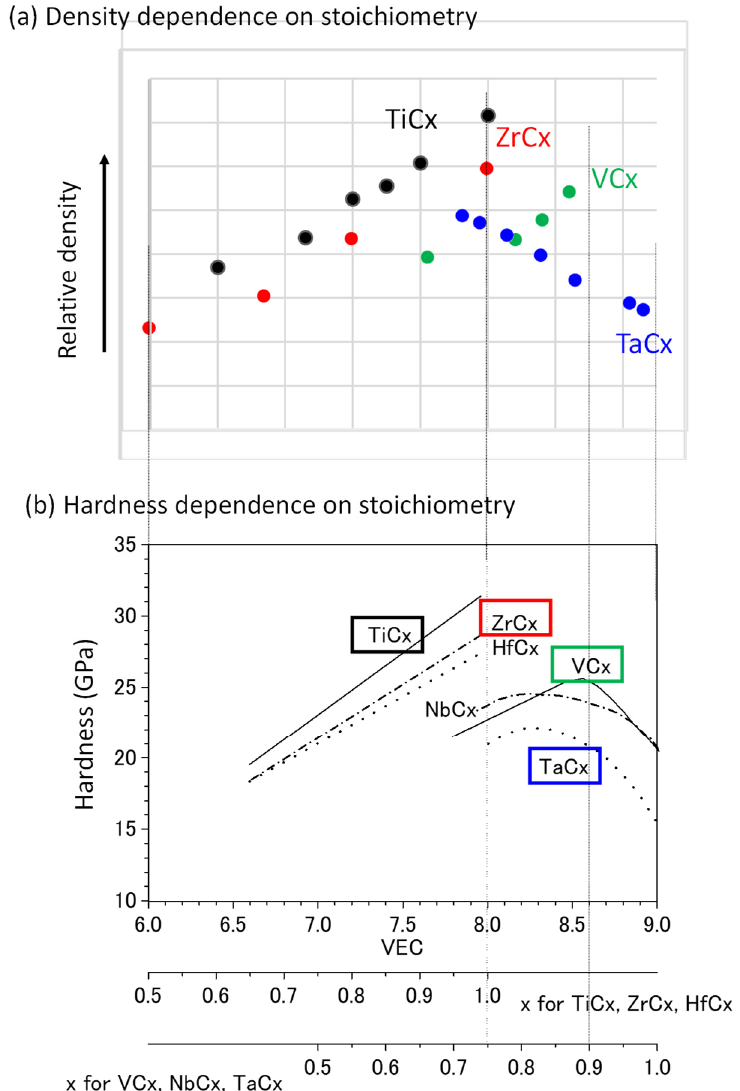
Figure 12. Composition dependence of density of TMCs ( a ) and with that of Vickers hardness [36] ( b ) for comparison. VEC is the abbreviation of “valence electron concentration” [36].